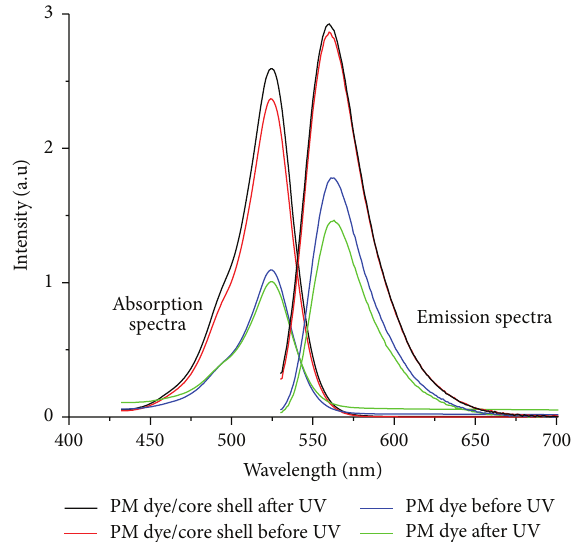
Figure5:ComparisonofabsorptionandemissionspectraofPM597 dyeandPM597/SiO 2 core/shellNPsbeforeandafterUVirradiation.